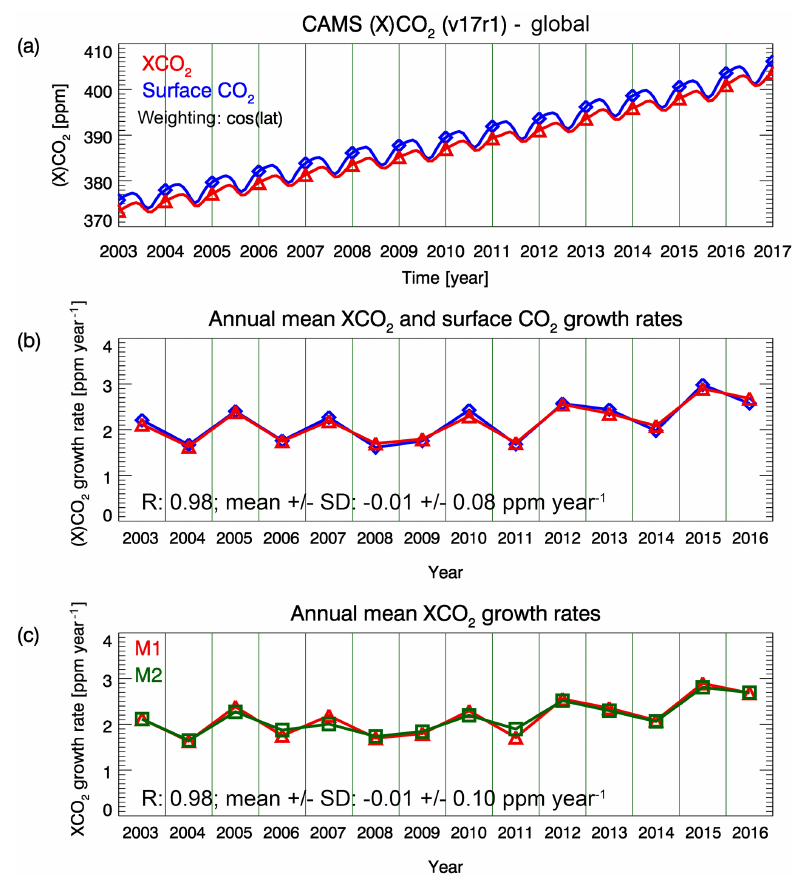
Figure A3. (a) Monthly mean global time series of XCO 2 (red) and surface CO 2 (blue) computed from a Copernicus Atmosphere Monitoring Service (CAMS) CO 2 reanalysis data product (version v17r1 obtained from http://apps.ecmwf.int/datasets/data/cams-ghg-inversions/ (last access: 13 November 2018); Chevallier, 2018). The symbols correspond to the values at the beginning and end of each year. (b) Annual XCO 2 (red) and surface CO 2 (blue) growth rates computed from the time series shown in (a) by computing for each year the difference between the values at the end and the beginning of that year (method M1). Also listed is the linear correlation coefficient R , the mean difference and the standard deviation of the difference. (c) The red symbols (and the red curve) show the same values as the red symbols shown in (b) ; i.e. they show annual XCO 2 growth rates computed using method M1. The green symbols also show XCO 2 annual growth rates but computed using the satellite method (M2), which is described in this